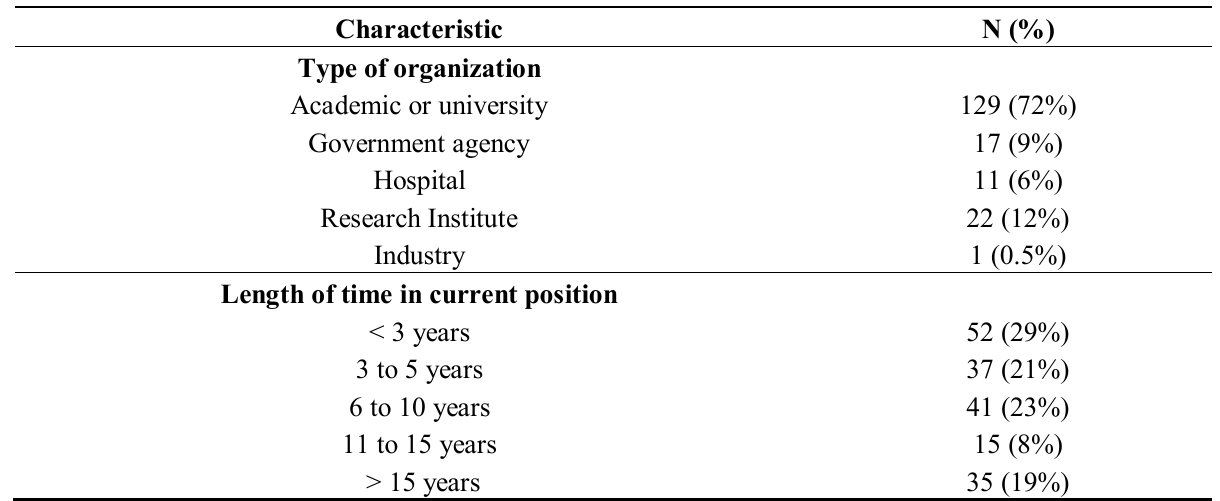
Table 2. Survey respondents’ position